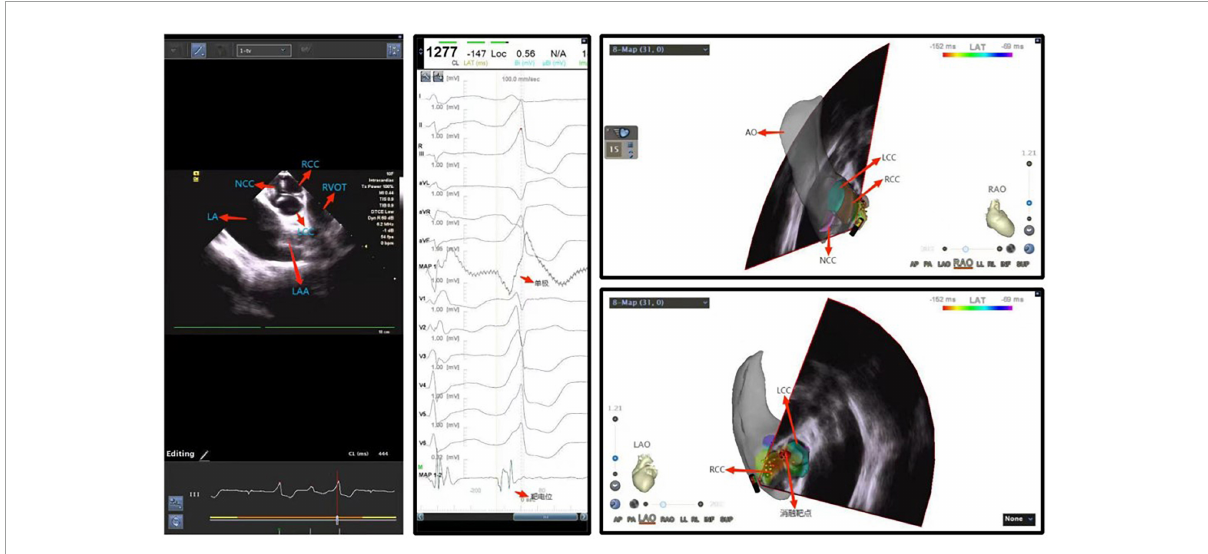
FIGURE4 Ventricular premature beat between left and right coronary cusps. NCC, non-coronary cusp; RCC, right coronary cusp; LCC, left coronary cusp; LA, left atrium; LAA, left atrial